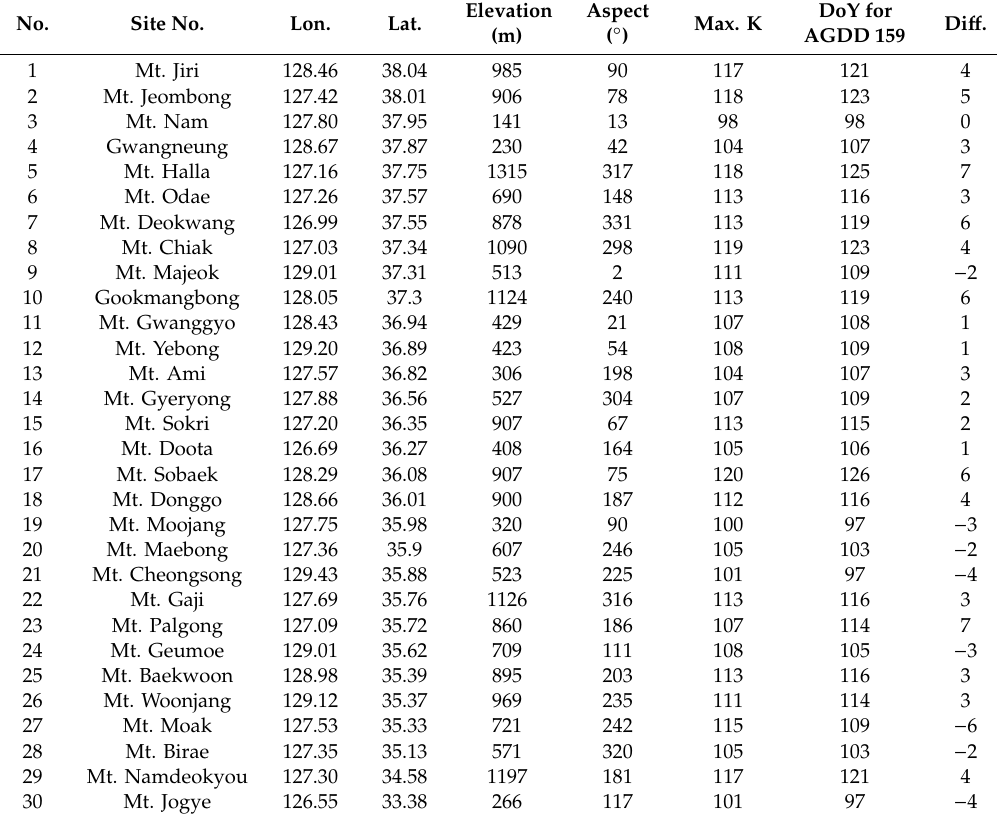
Table A1. The DoY reached the AGDD 159 and the green-up DoY in 2015 for 30 sampling sites of Quercus mongolica forest throughout South Korea. Max. K: DoY required for green-up start based on curvature K, Di ff .: Di ff erence between days deducted based on AGDD 159 and curvature K.